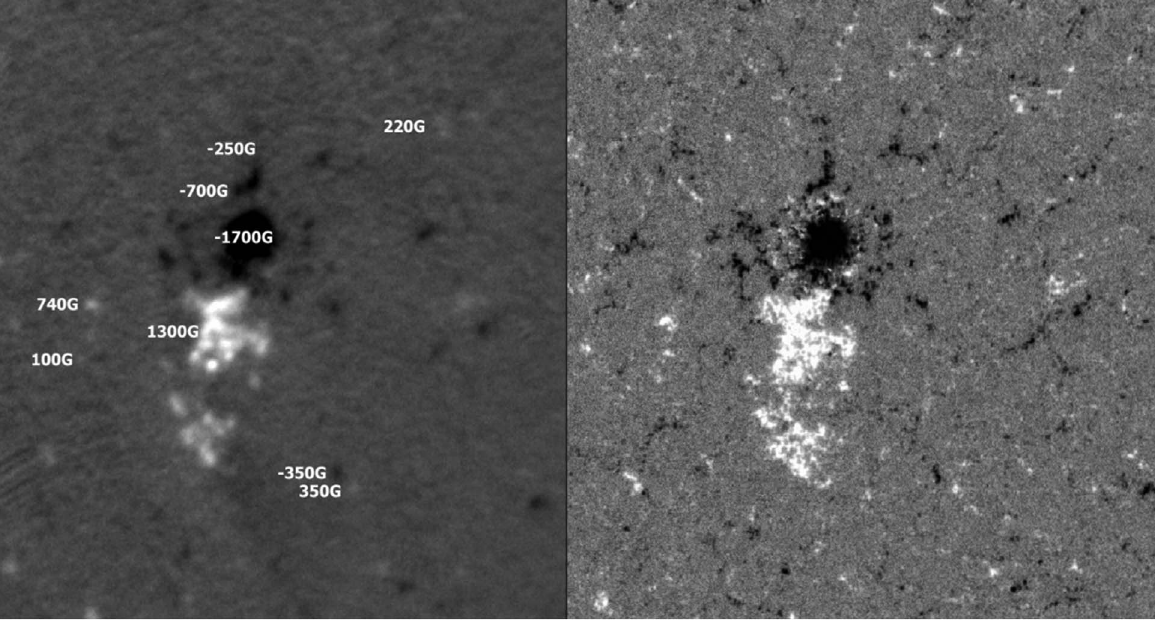
Fig. 12. Comparison between the K magnetogram of SAMM (left) and SDO (right) of the active region 12,757 (Courtesy of NASA/SDO and the AIA, EVE, and HMI science teams). FOV: 5.5 0 (cid:3) 5.5 0